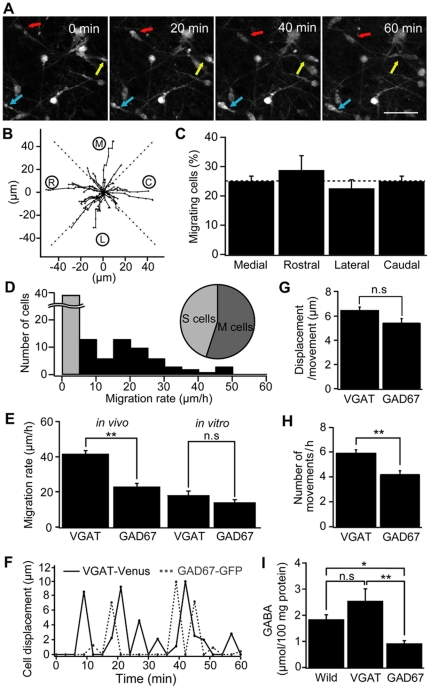
Comparison of multidirectional migration between GAD67-GFP and VGAT-Venus mice.(A) Time-lapse images of migrating neurons in the MZ of a P2 GAD67-GFP mouse. Times shown at the upper right represent the time elapsed after starting the observation. Each GABAergic interneuron is marked by a red arrow. Scale bar = 40 µm. (B) The trajectory of migrating neurons in GAD67-GFP mice (n = 45 cells, 4 animals at P0–P3). The initial location of each neuron at start time of imaging is normalized to the center position. Black filled circles in each line represent the location of each neuron observed at 3 minutes interval. M: medial; C: caudal; L: lateral; R: rostral. (C) The proportion of neurons moved toward each direction. Dotted line is drawn at 25% level. (D) Histogram of the migration rate. Gray bar indicates the number of stationary cells which migrate less than 5 µm during 1 hour. Inset indicates the proportion of cells showing a moving or stationary behavior. (E) Comparison of average displacements per 1 hour between VGAT-Venus and GAD67-GFP mice in vivo and in vitro, using horizontal slices of neocortex. (F) Cell displacements plotted as a function of time which shows the discontinuous translocation of the cells. Time interval between each observation is 3 minutes. (G) Average distance during each moving phase of VGAT-Venus and GAD67-GFP mice in vivo (p>0.05). (H) The frequency of moving phase of VGAT-Venus and GAD67-GFP mice in vivo (**p<0.01). (I) Summary graph of GABA contents by using high-performance liquid chromatographic (HPLC) analysis in the cerebral cortex of neonatal (P0–P3) wild type (n = 10), VGAT-Venus (n = 9) and GAD67-GFP (n = 9) mice (*p<0.05, **p<0.01). The levels of GABA were expressed as micromoles/100 mg proteins. Each column indicates mean ± SEM.